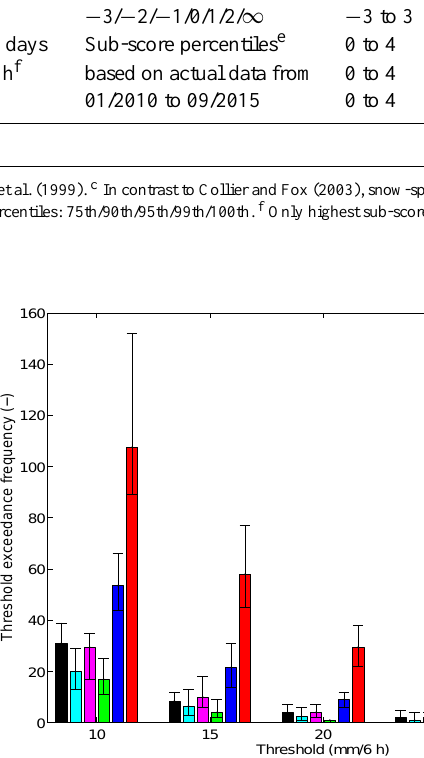
Figure 3. Threshold exceedance frequencies of 6-hourly areal pre- cipitation sums for QPEs (gridded rain gauge data, RADOLAN- RW) and QPFs (COSMO-DE, Quantile Forecast) from April 2011 to June 2014. The bars show the median of exceedance frequencies for the respective precipitation products for the 16 forecast areas